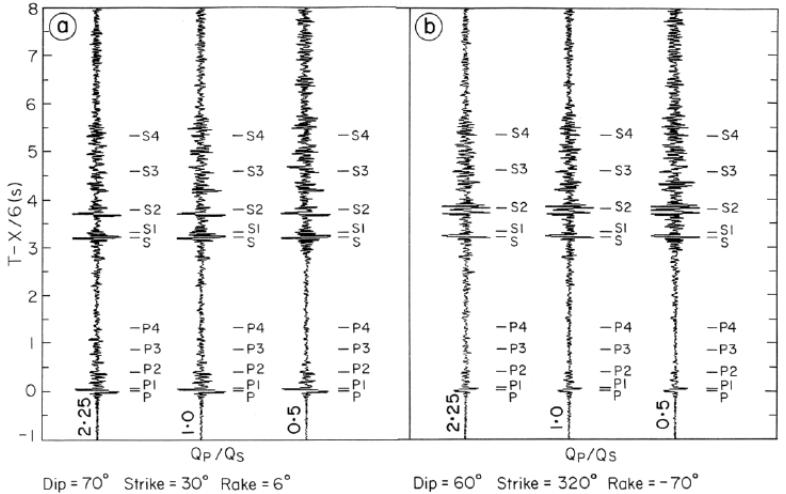
/Q ratios in seismograms for (a) strike-slip, and (b) normal P S